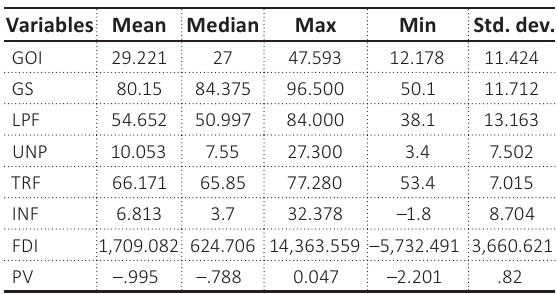
Table 2. Summary of descriptive